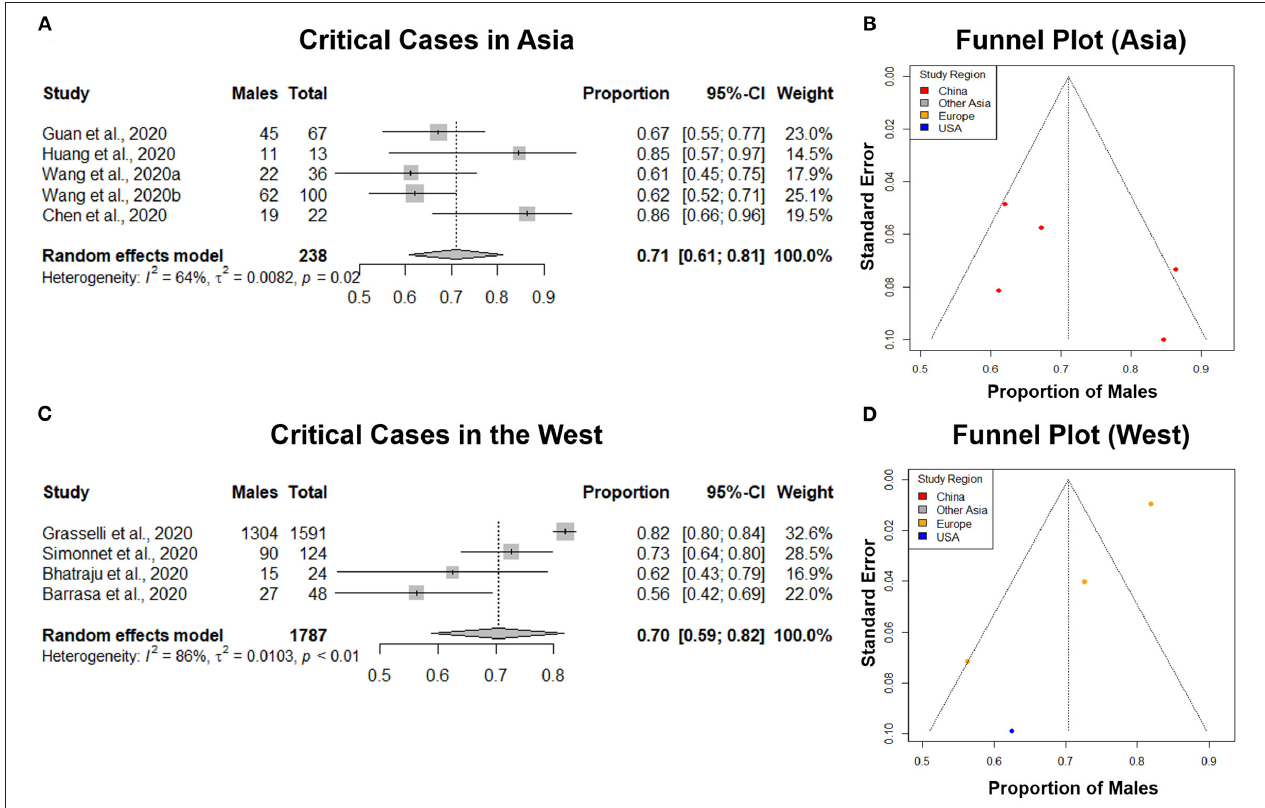
FIGURE 6 | Comparison of the proportion of males in COVID-19 critical cases in Asia and the West. (A,C) Forest plot of sex-distribution in COVID-19 critical cases in each of the studies. Proportions of males and the 95% confidence intervals (CIs) are indicated. The vertical dotted lines represent the combined proportion of all studies. The diamond represents the combined 95% CI, the left and right endpoints of which are the lower and upper bounds of the CI, respectively. Critical case defined as: received mechanical ventilation, clinically diagnosed with shock, received care in the intensive care unit (ICU), or transferred to a tertiary care hospital. (A) Critical cases in Asian countries. (C) Critical Cases in western countries. (B,D) Funnel plot with 95% confidence region of sex-distribution in COVID-19 critical cases in each of the